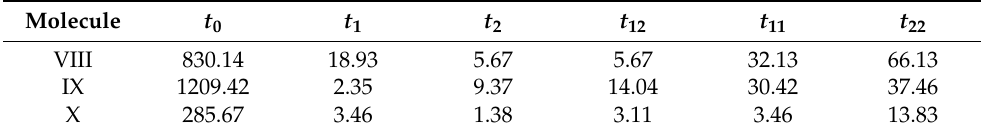
Table 6. t -Student coefficients.